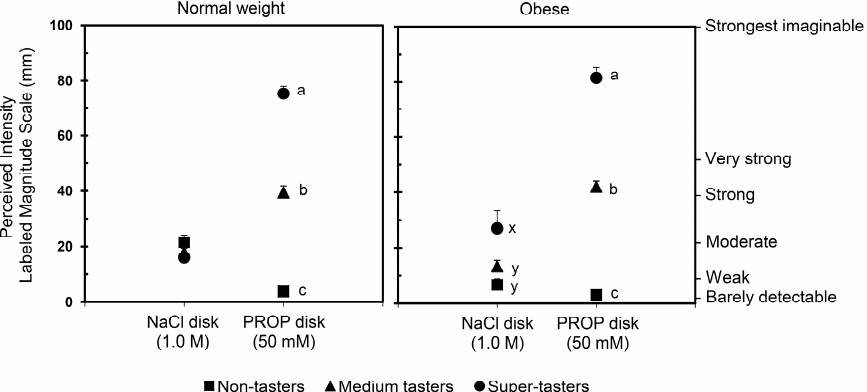
Figure 4. Mean (±SE) values of perceived intensity NaCl and PROP in an ethnically homogeneous cohort of Sardinia, Italy. n = 134 (48 Males, 86 Females) normal weight subjects; n = 98 (45 Males, 53 Females) obese subjects. Values with different superscripts (a, b, etc.) indicate significant differences ( p < 0.034; Duncan’s test subsequent 2-way-ANOVA).